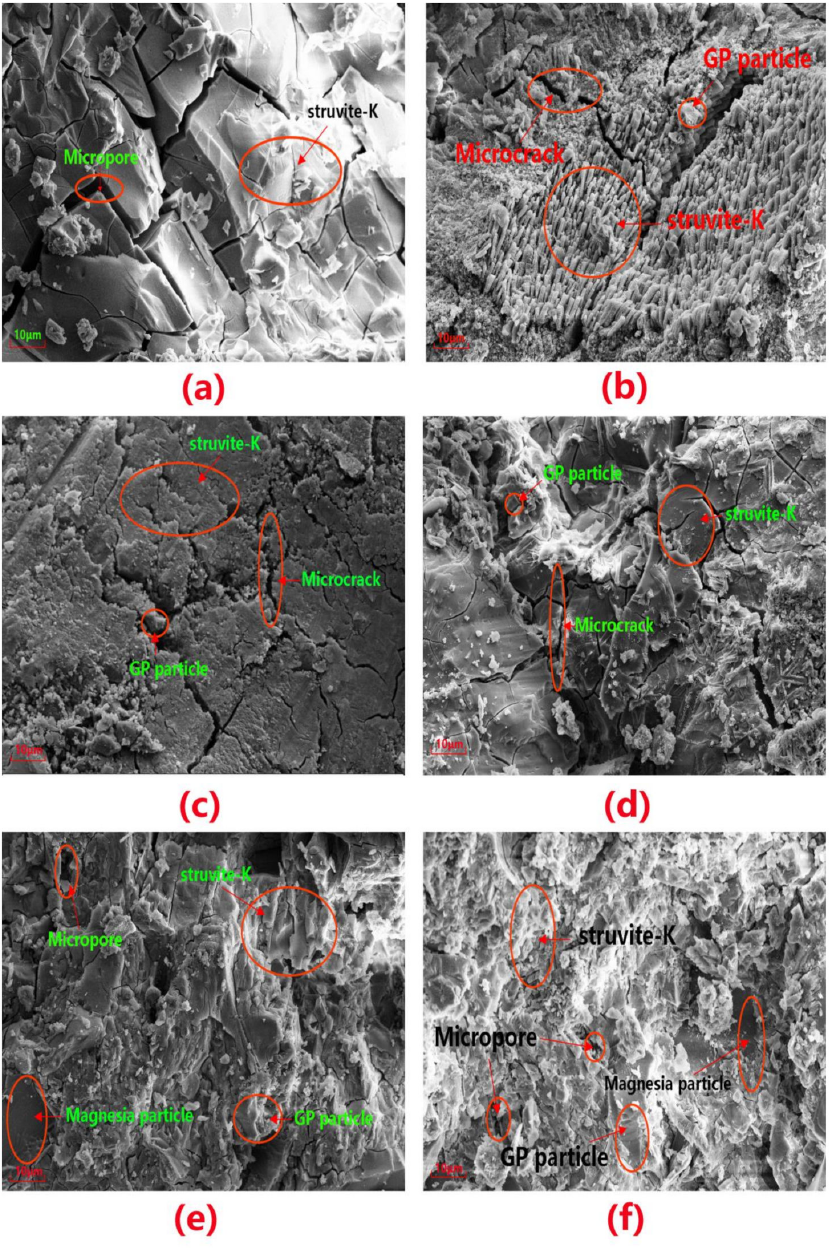
Figure 9. SEM images of the MKPC pastes cured for 28 days: ( a ) G1-0 ( b ) G1-1 ( c ) G1-2 ( d ) G1-4 ( e ) G2-4 and ( f )